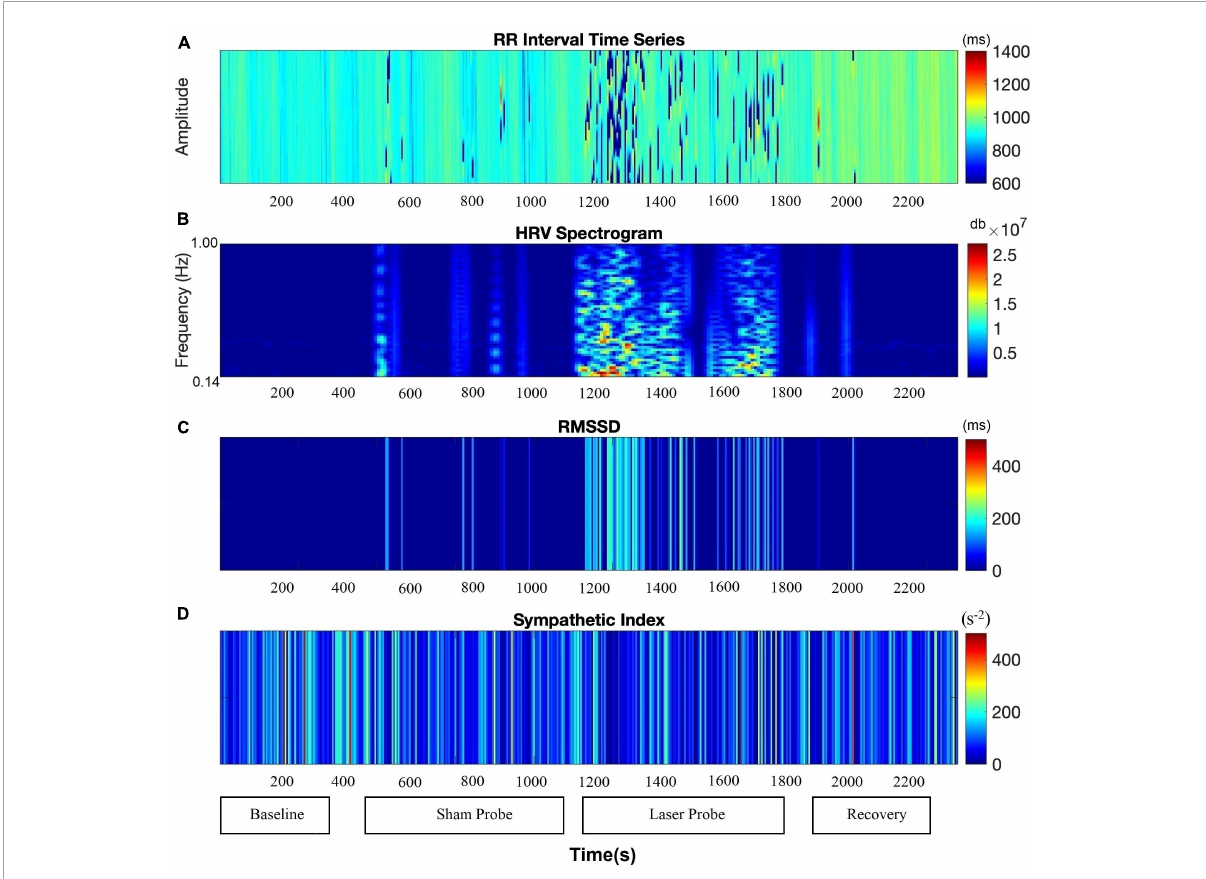
FIGURE6 Comparison of autonomic nervous system activity during the application of the probe procedure with and without (sham) activating the probe. (A) RR Intervals time series, (B) HF band power, (C) RMSSD, (D)